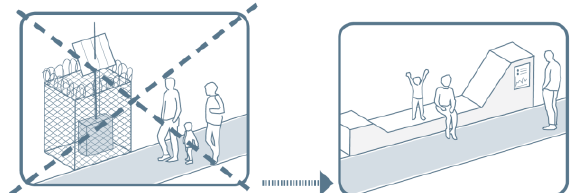
Figure 3: Spatial Integration of Early Warning and Sensing System (Werthman,